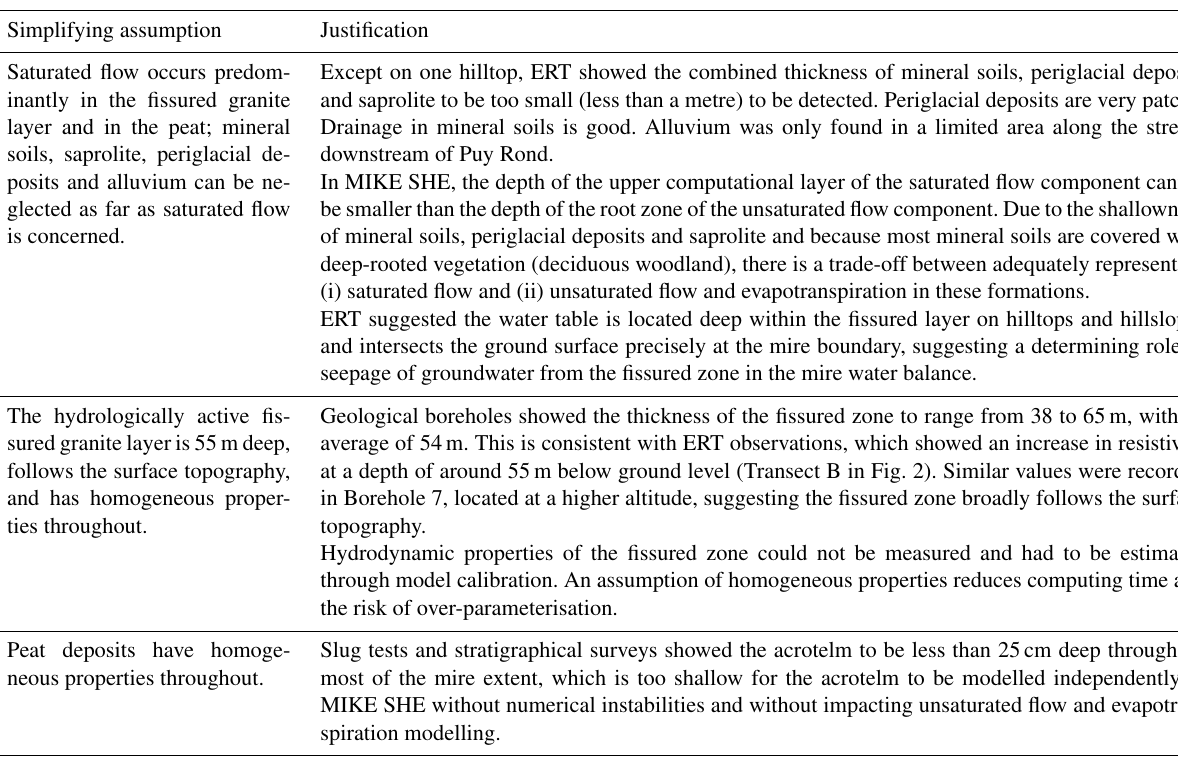
Table 1. Justification of simplifying assumptions of the saturated flow model component. Simplifying assumption